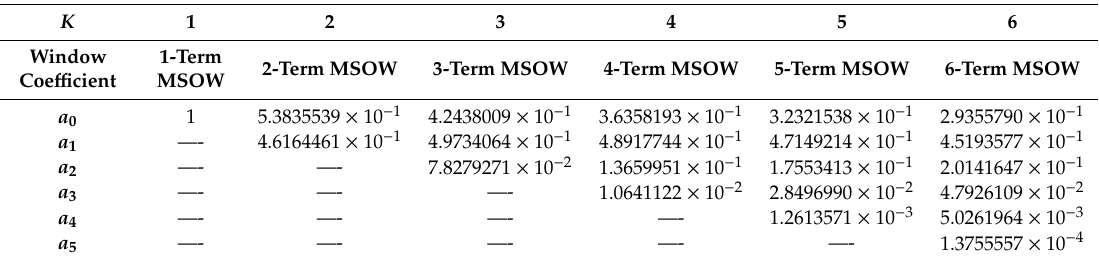
Table 2. Coe ffi cient of the minimum side-lobe optimization window (MSOW).